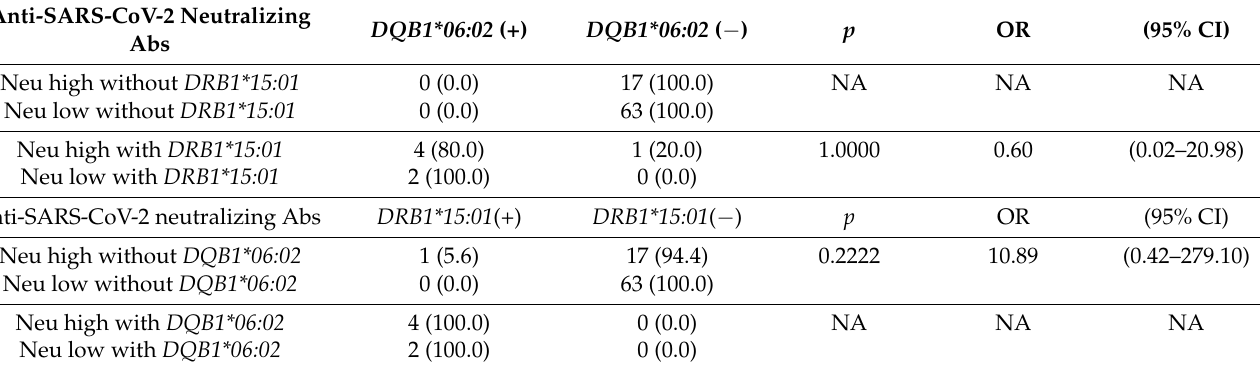
Table 5. DRB1*15:01 and DQB1*06:02 carrier frequency in RA patients with or without DRB1*15:01 or DQB1*06:02 : associations with anti-SARS-CoV-2 neutralizing